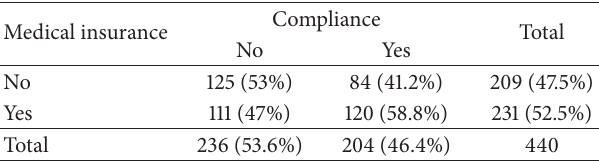
Table 5: Effect of medical insurance on compliance to antiglaucoma medications.